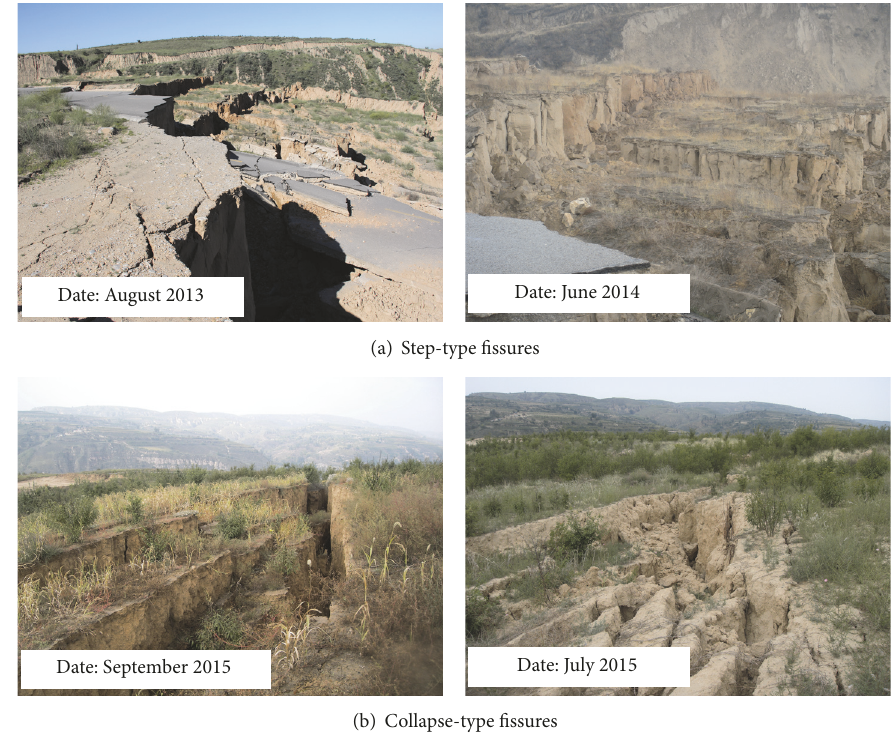
Figure 1: Morphological development of damaging surface fissures and their impact on